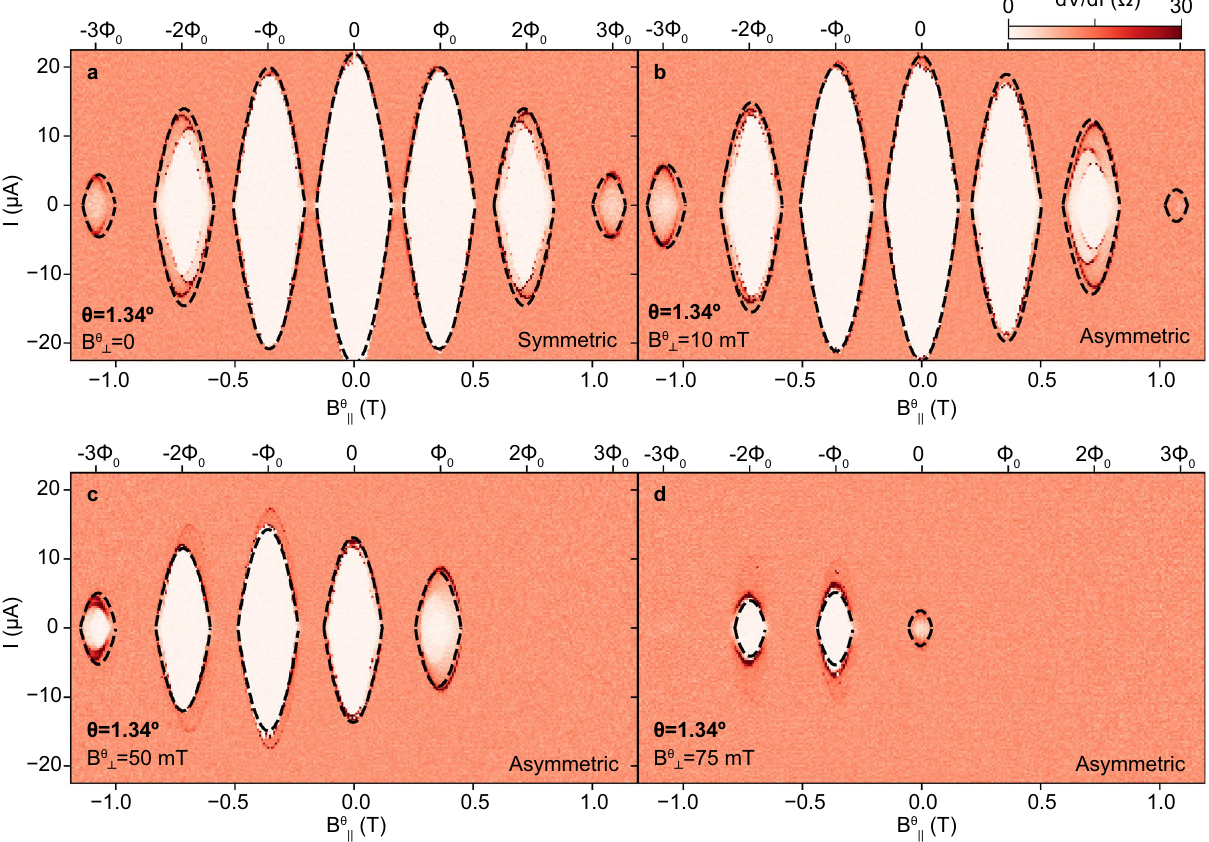
Figure 3. Asymmetric Little–Parks effect in the destructive regime (Device 2). ( a – d ) Little–Parks data and fit for Device 2, akin to those shown in Fig. 2a–c. The misalignment angle θ = 1.34 ◦ is kept fixed in ( a – d ). The misaligned perpendicular field, B θ ⊥ , is progressively increased as indicated in each panel, leading to an increased asymmetry in the Little–Parks oscillations of the critical current, I c . Fit parameters are given in Table